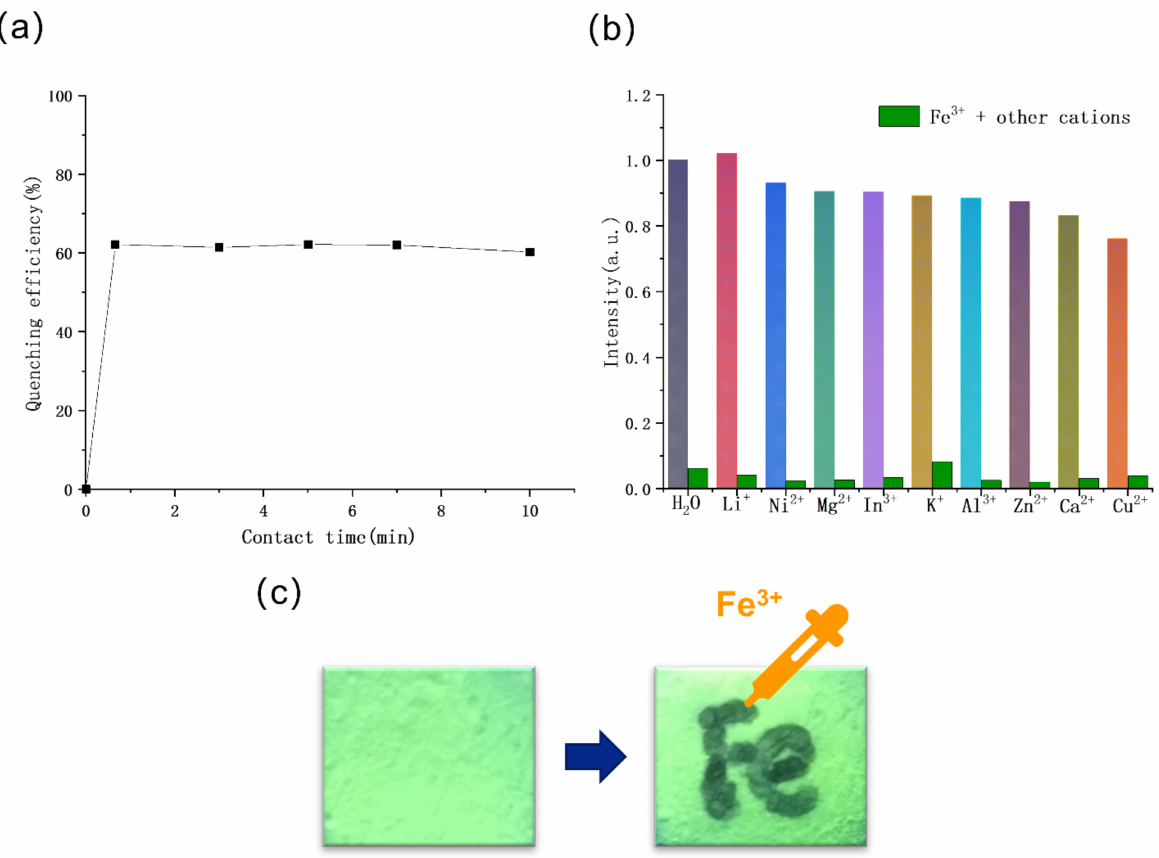
Figure 5. ( a ) Time-dependent quenching efficiency of 2 in the presence of Fe 3+ solutions (3 × 10 − 4 M). ( b ) Comparison of the 5 D 4 → 7 F 5 photoluminescence intensity of compound 2 in the pure individual metal ions and mixed metal ions containing 1 mM of Fe 3+ ion. ( c ) The image of 2 paper-coated sensor treated with 0.01 M Fe 3+